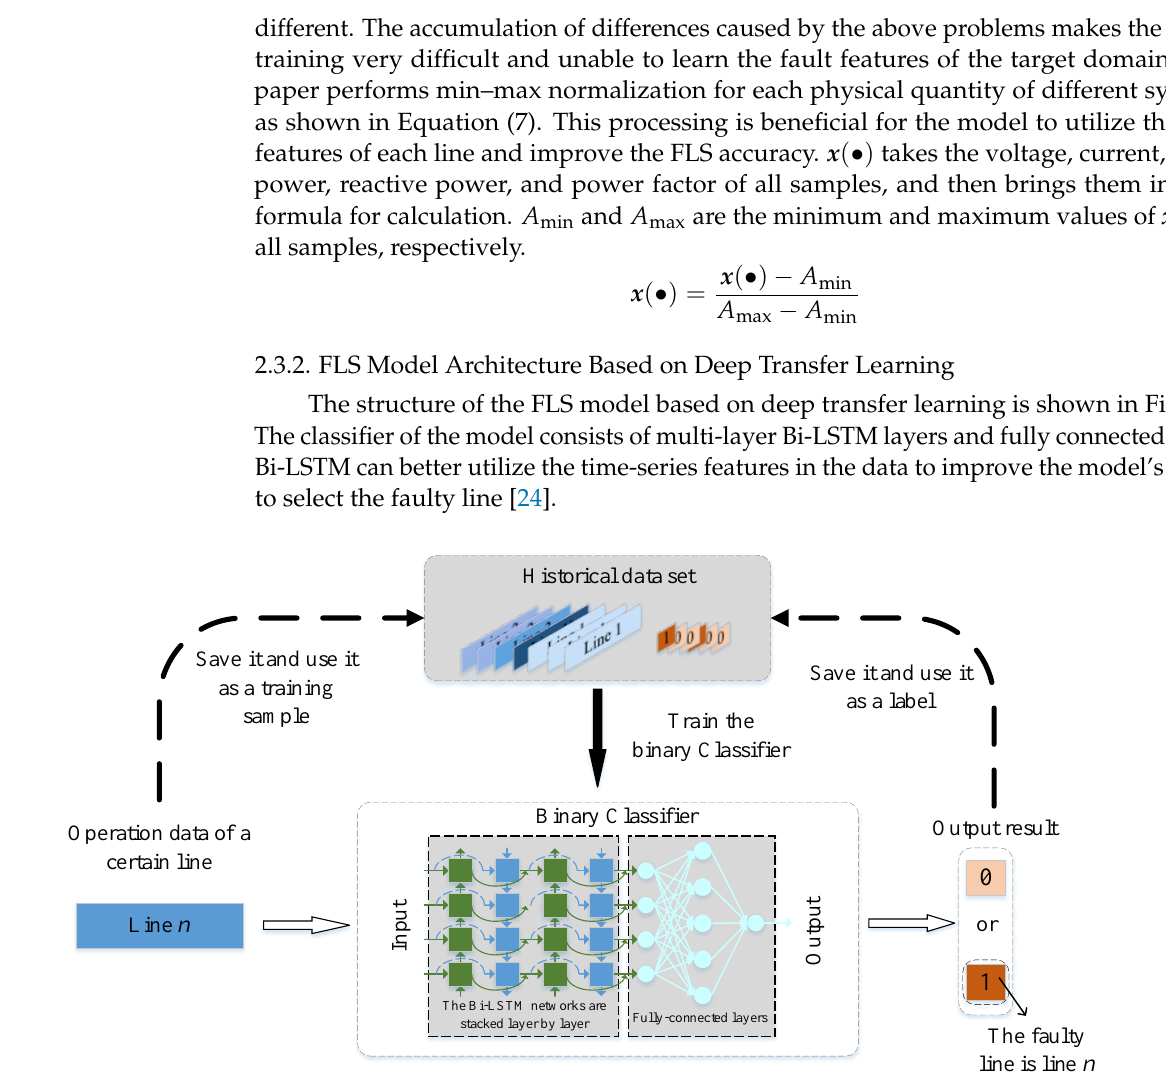
Figure 3. FLS model architecture based on deep transfer learning.